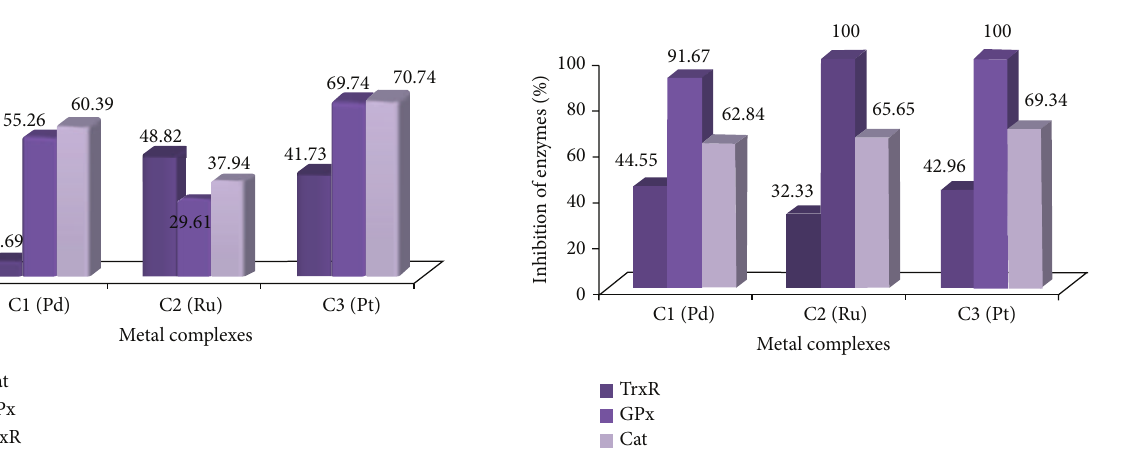
Figure 8: Percentages of inhibition of TrxR, GPx, and Cat enzymes of K562 cells in the given period, after incubation, with IC 50 values of C1, C2, and C3